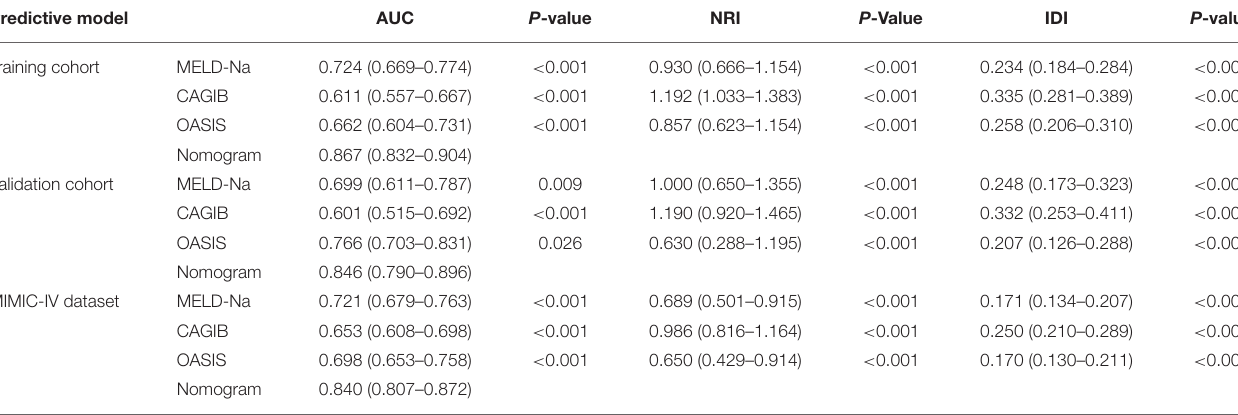
TABLE 3 | Comparison of models in predicting the in-hospital death of LCEV patients. Predictive model